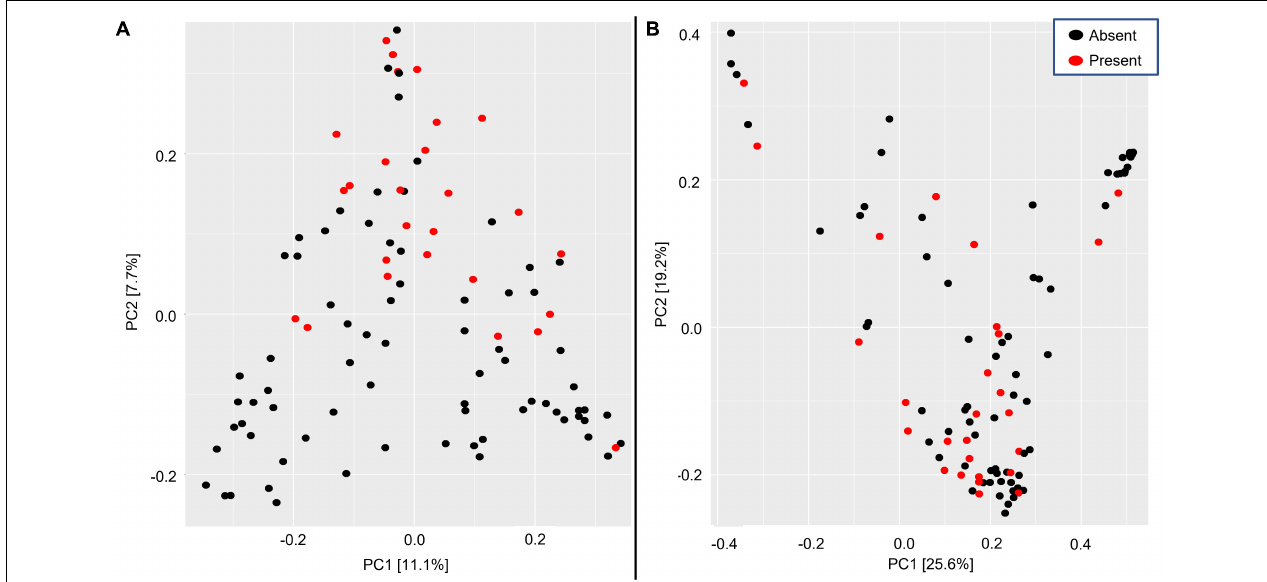
FIGURE 4 | Principal coordinate analysis plots showing the bacterial communities in barn swallow ( Hirundo rustica ) fecal samples with Salmonella (present: red dots) and without (absent: black dots) by (A) unweighted UniFrac and (B) weighted UniFrac metrics. The amount of the variation explained by each axis is in brackets. Bacterial beta diversity significantly differed for both metrics ( p = 0.001 for both) between Salmonella- present and -absent birds.